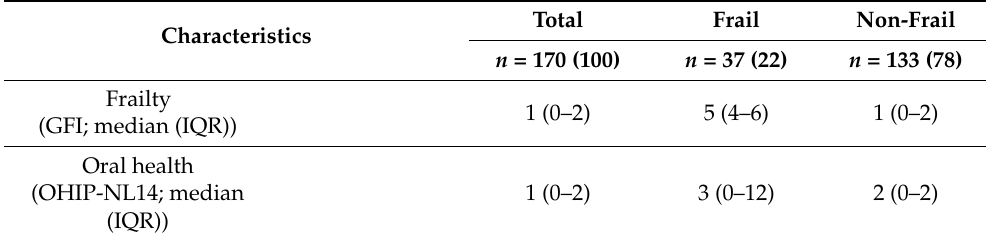
Table 1. Baseline characteristics of participants overall and by frailty status.